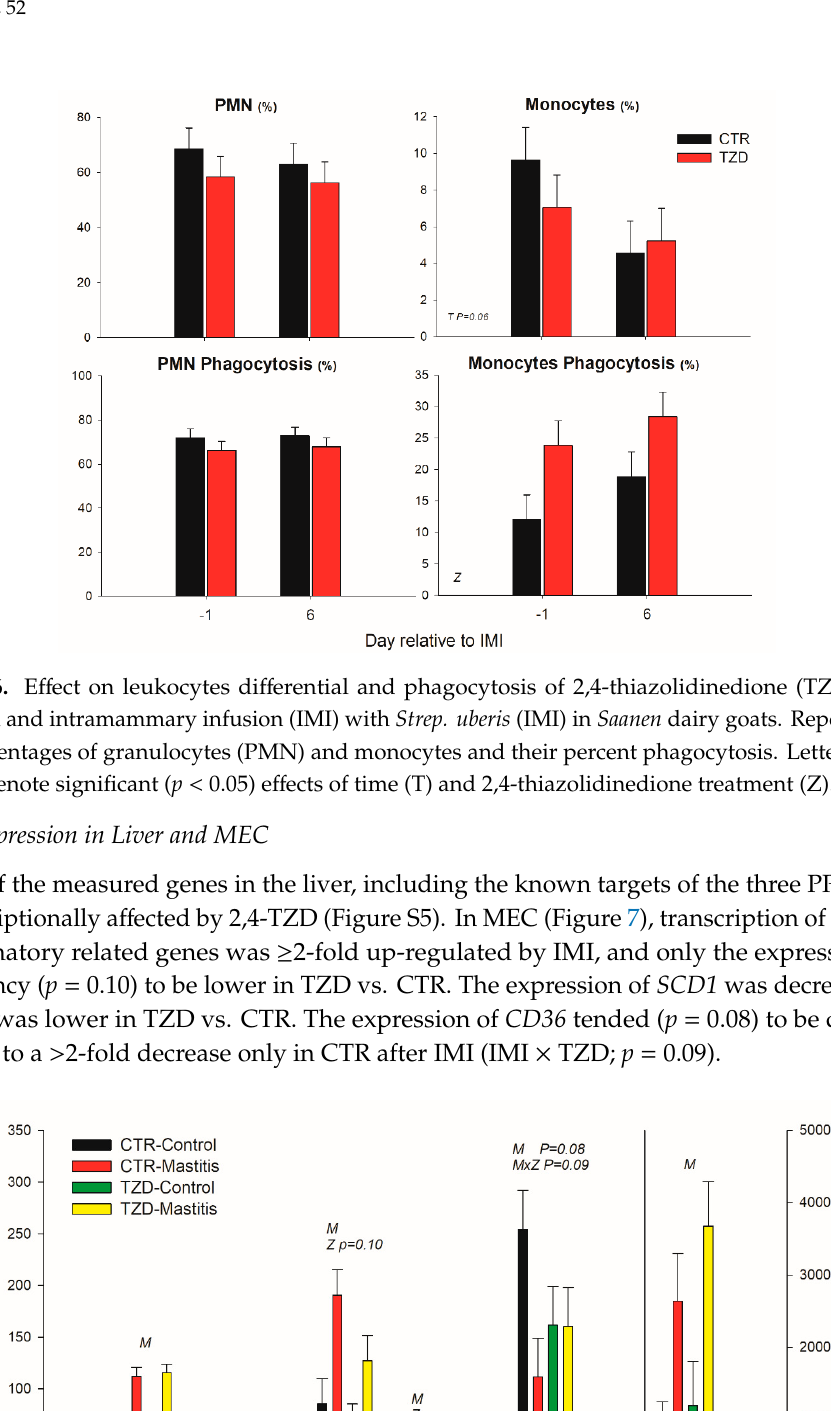
Figure 7. Effect on expression of inflammatory ( NFKB1 , TNFA , CCL2 , and IL8 ) and milk fat synthesis ( SCD1 , CD36 ) related genes in mammary epithelial cells isolated from the milk of Saanen goats receiving either intrajugular daily injection of 2,4-thiazolidinedione (TZD) or saline (CTR) and intramammary infection in the right half of the mammary gland by infusing Strep. uberis (Mastitis) while the left half of the mammary gland was left untouched (Control). Cells were isolated 5 days post-intramammary infection. Letters in the plot denote overall statistical ( p ≤ 0.05) effect for IMI (M), 2,4-thiazolidinedione treatment (Z), or interaction (M × Z). When a tendency was detected, the p -value is reported.